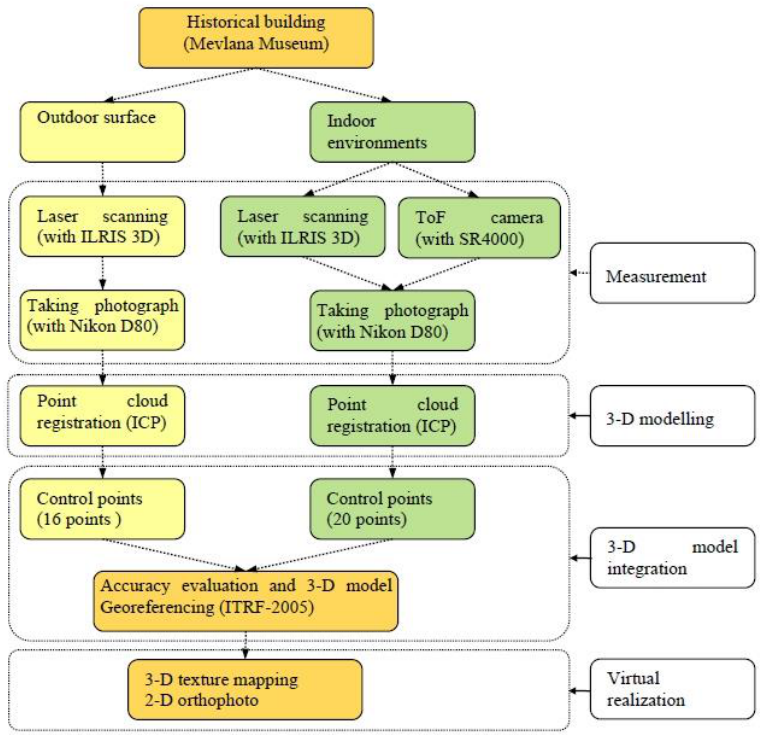
Figure 3. The flowchart of the surveying and 3-D modeling methodology.